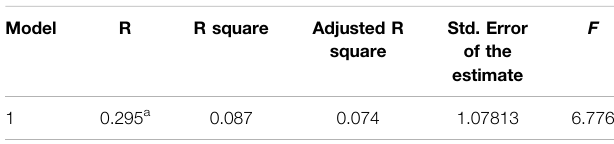
TABLE 5 | Case B: H2. Regression model